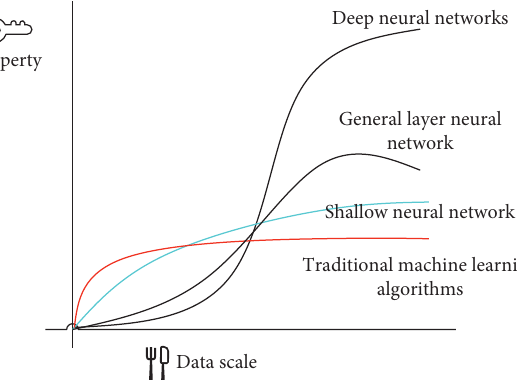
Figure 2: The relationship between model performance and data